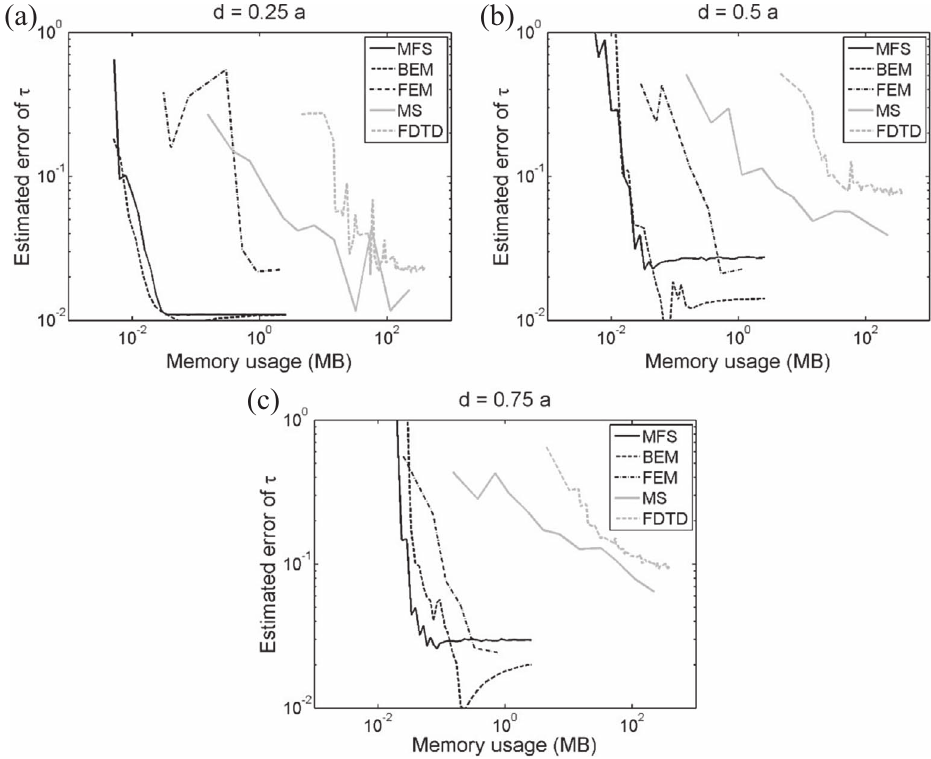
Figure 4. Estimated error of the global transmission coef fi cient s versus memory usage for all the studied methods: (a) d = 0.25 a ; (b) d = 0.5 a ; (c) d = 0.75 a .